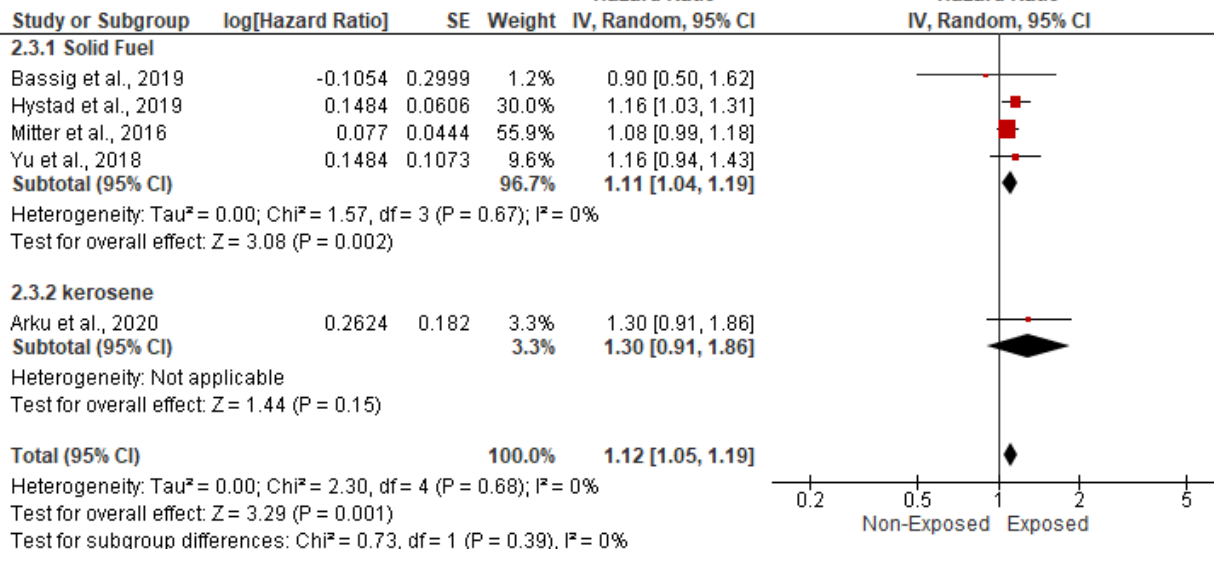
Figure 9. Forest plot of subgroup analysis of the hazard ratio and 95% CI of the association between HAP and cerebrovascular accidents based on types of HAP. The size of the red squares is proportional to the statistical weight of each trial. The gray diamond represents the pooled point estimate. The positioning of both diamonds and squares (along with 95% CIs) beyond the vertical line (unit value) suggests a significant outcome (IV = inverse variance).